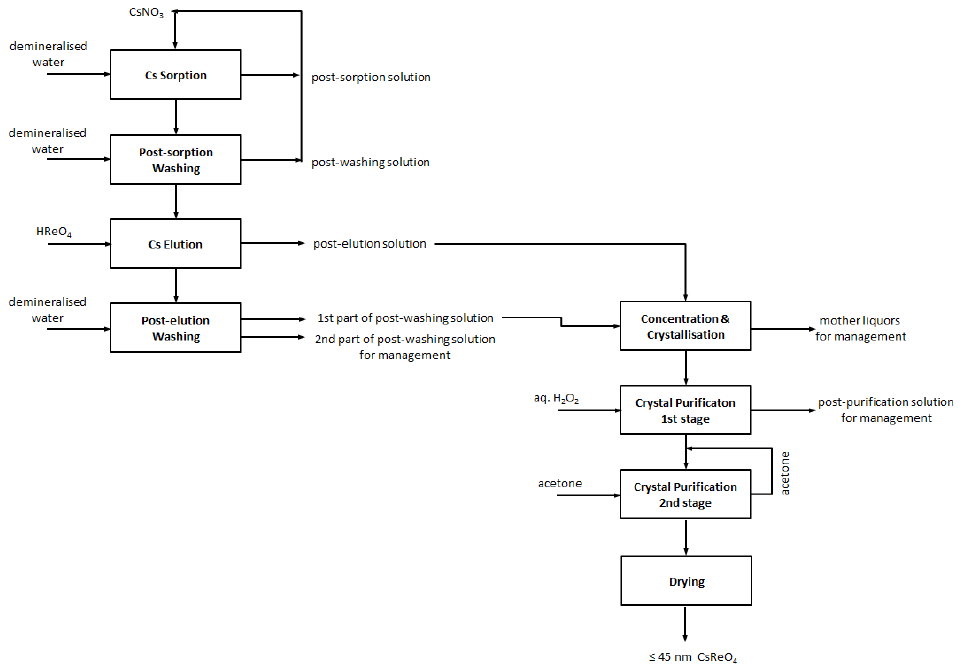
Figure 8. Technological scheme of anhydrous nanocrystalline cesium perrhenate preparation.